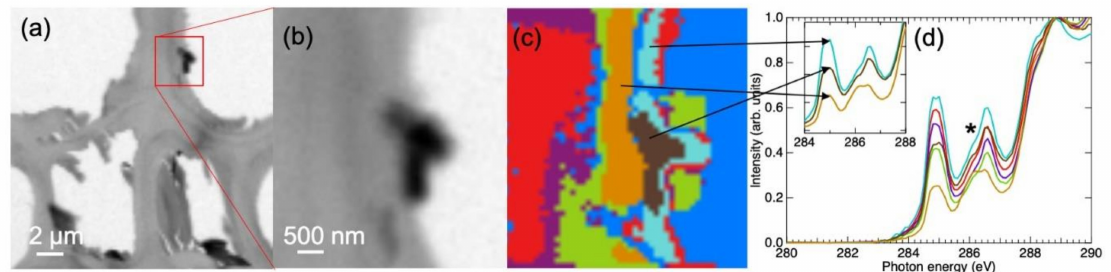
Figure 3. ( a ) An overview image of a cryosectioned Norway spruce section recorded at 320 eV, ( b ) a zoom to a material deposit from where the energy stack was collected, ( c ) a cluster analysis of the material deposit based on the energy region 280–290 eV, ( d ) XAS of clusters with the same colour coding. The spectrum of the empty region depicted in blue in ( c ) is not shown. The inset shows a comparison of three cluster XAS with varying aromatic contribution (highest shown in